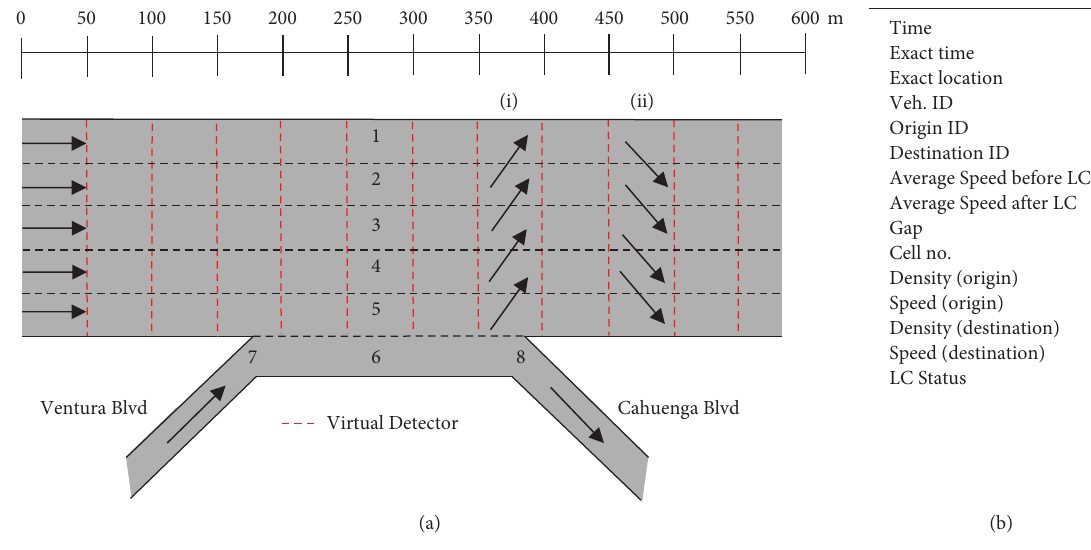
Figure 5: (a) US-101 study area and (b) outputs of processed